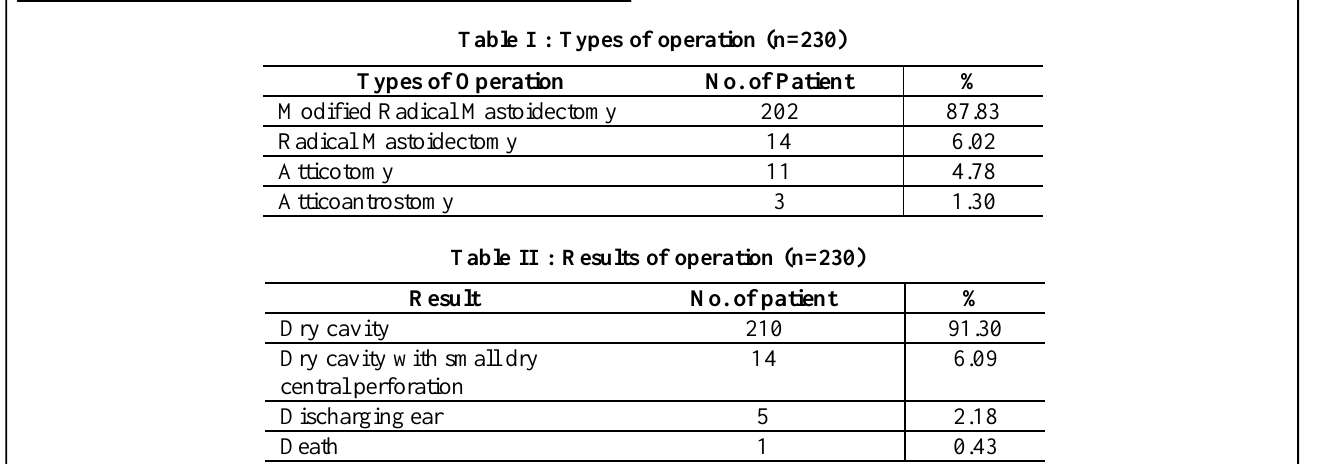
Fig. 1 : Otoscopic